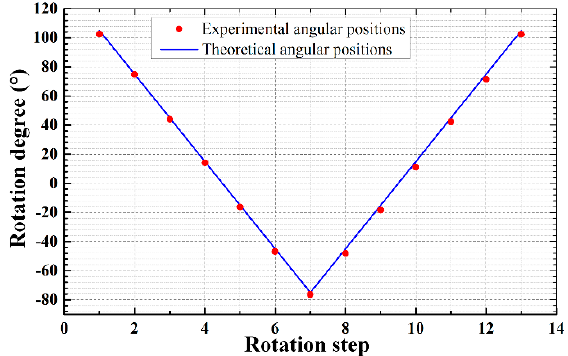
Figure 12. Measured and theoretical angular in the process of alternating the particle rotation direction.